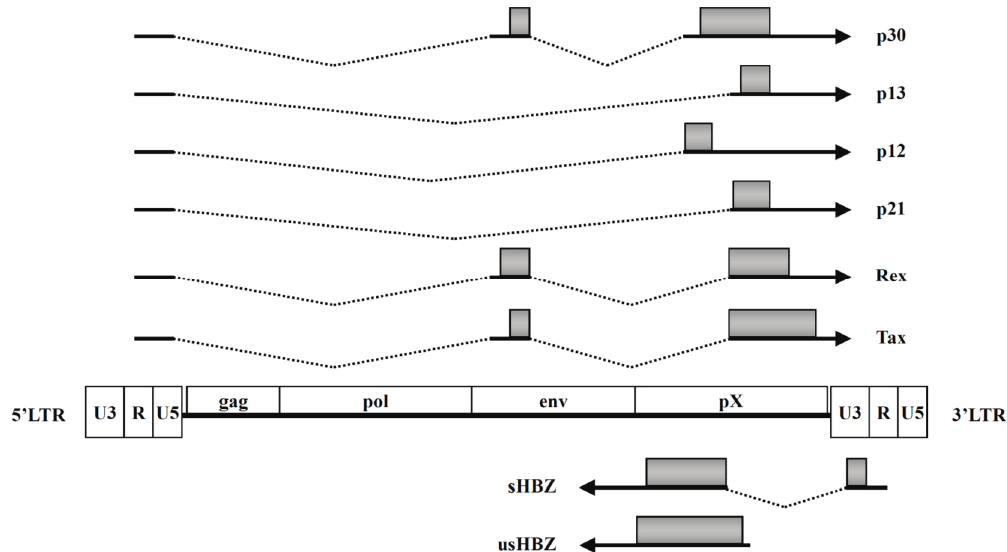
Figure 1. Regulatory and accessory genes encoded by HTLV-1. p12, p13, p30, Rex, p21, and Tax are transcribed from the 5' long terminal repeat (LTR). HBZ is located on the complementary proviral strand and transcribed from the 3' LTR. Spliced (s) and unspliced (us) HBZ are shown. Shaded boxes represent their coding regions.